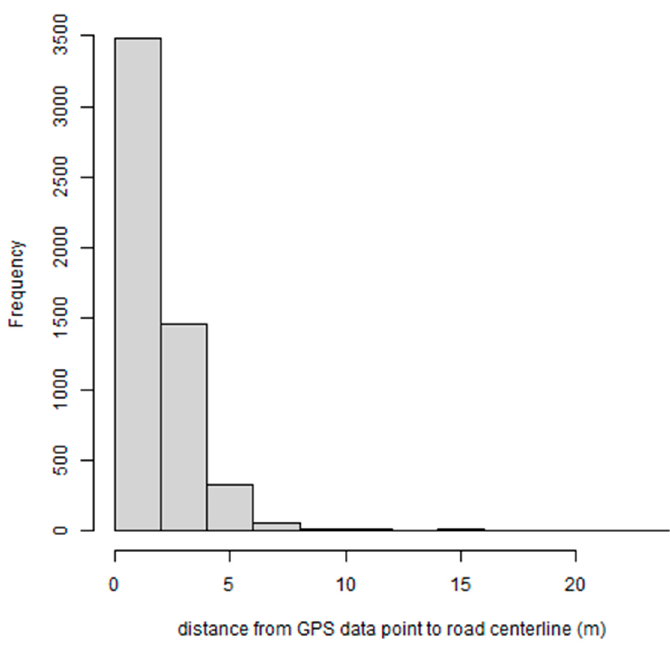
Figure 5. Distribution of distances between GPS data points and the centerline of official road sections in the validation section.